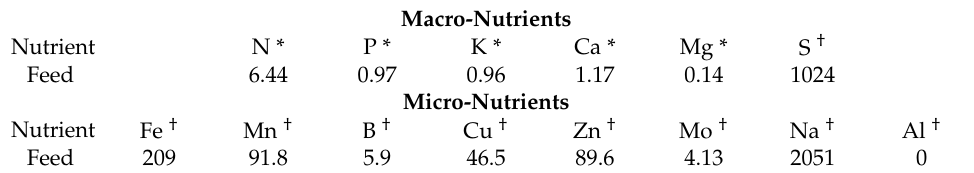
Table 1. Feed nutrient profile. The nutrient profile of Zeigler Bros. Inc., Finfish Silver, 40% protein, 10% lipid feed.